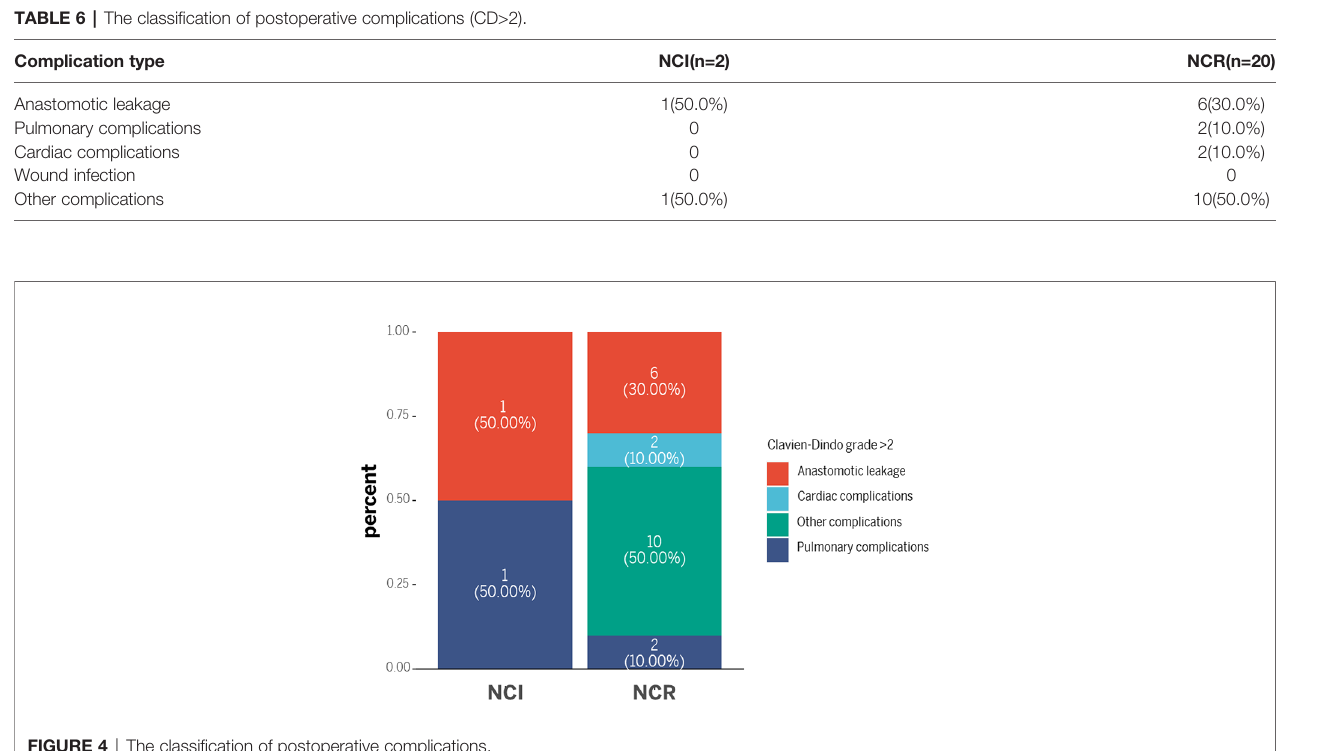
FIGURE 4 | The classi fi cation of postoperative